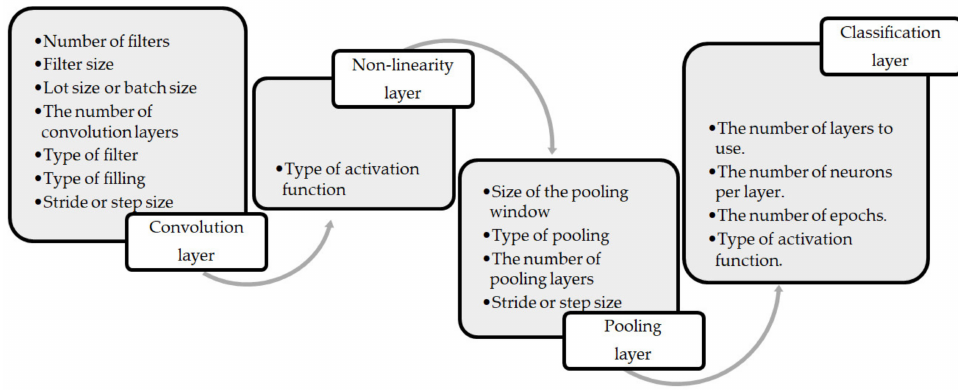
Figure 2. Layers and the parameters per layer of a CNN.